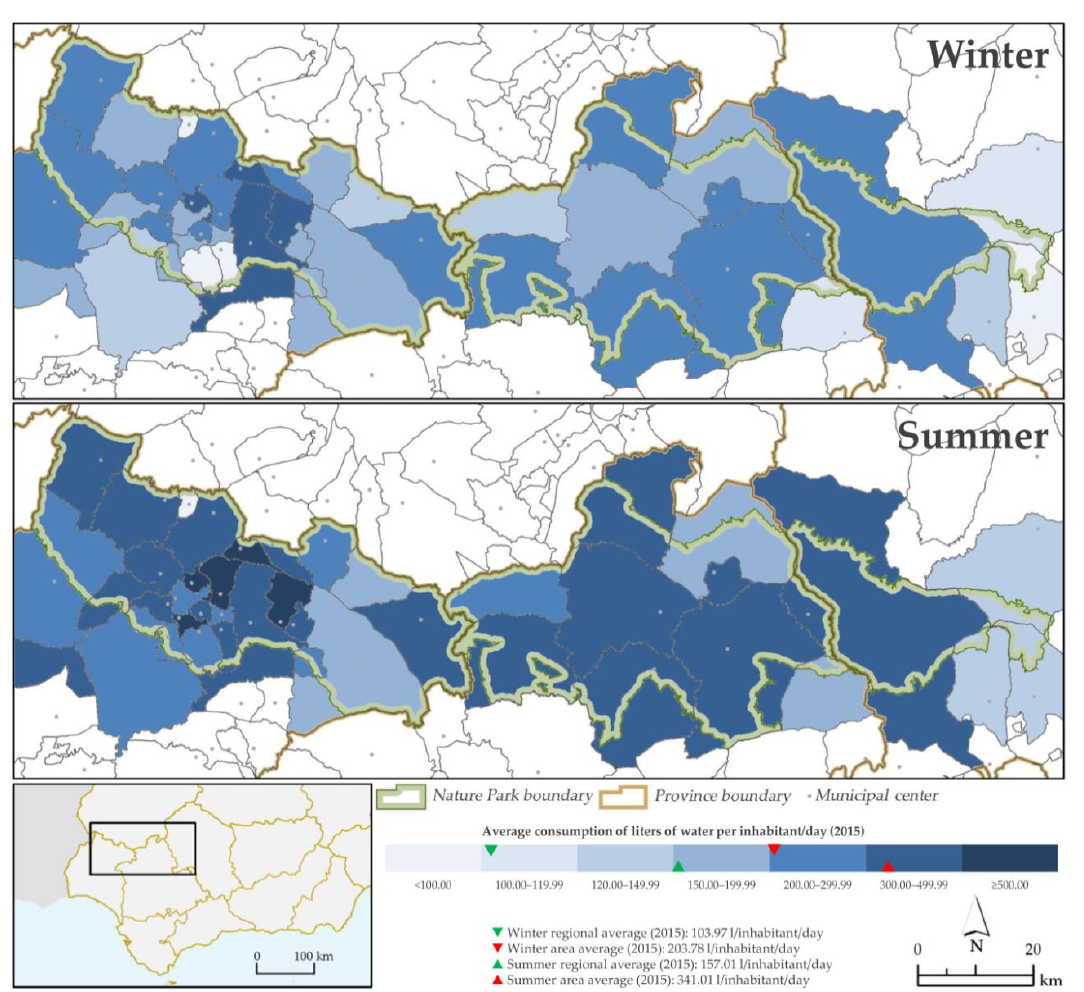
Figure 10. Municipal water consumption in the area in winter and summer (2015). Source: [85]; authors ’ elaboration.